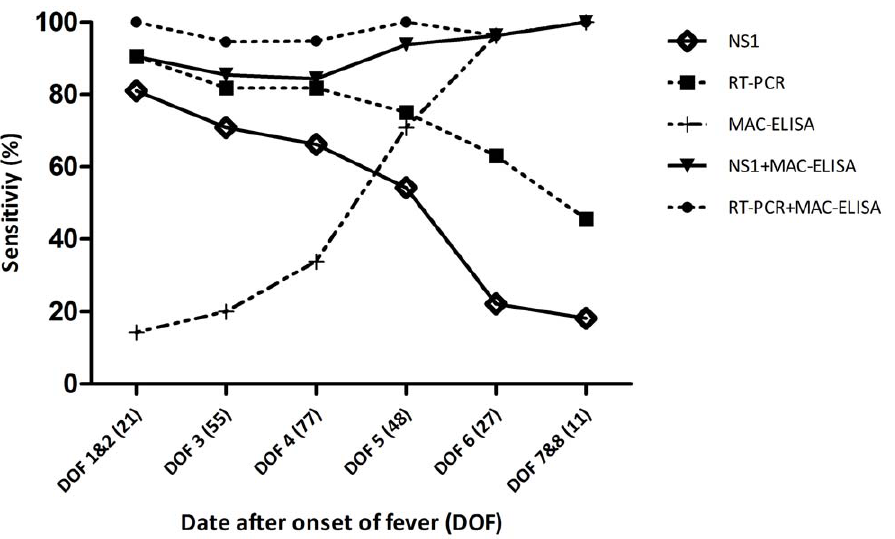
Figure 1. Sensitivity of Platelia NS1, MAC-ELISA and RT-PCR depending on DOF* (n=239). *DOF: Day after onset of fever.